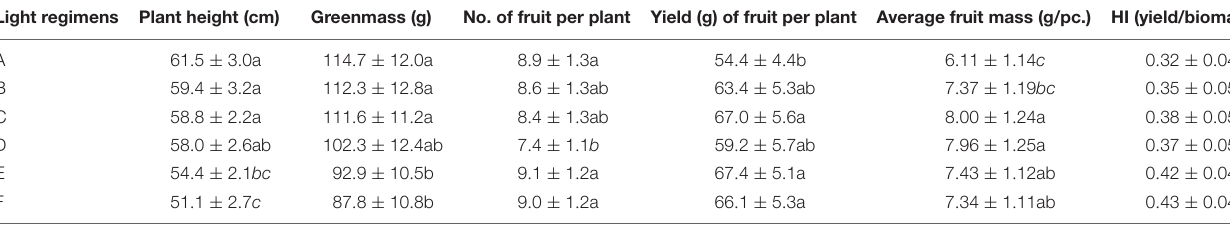
TABLE 2 | Plant morphology and biomass production of chilli grown under different light regimens (A–F). Light regimens Plant height (cm) Greenmass (g)